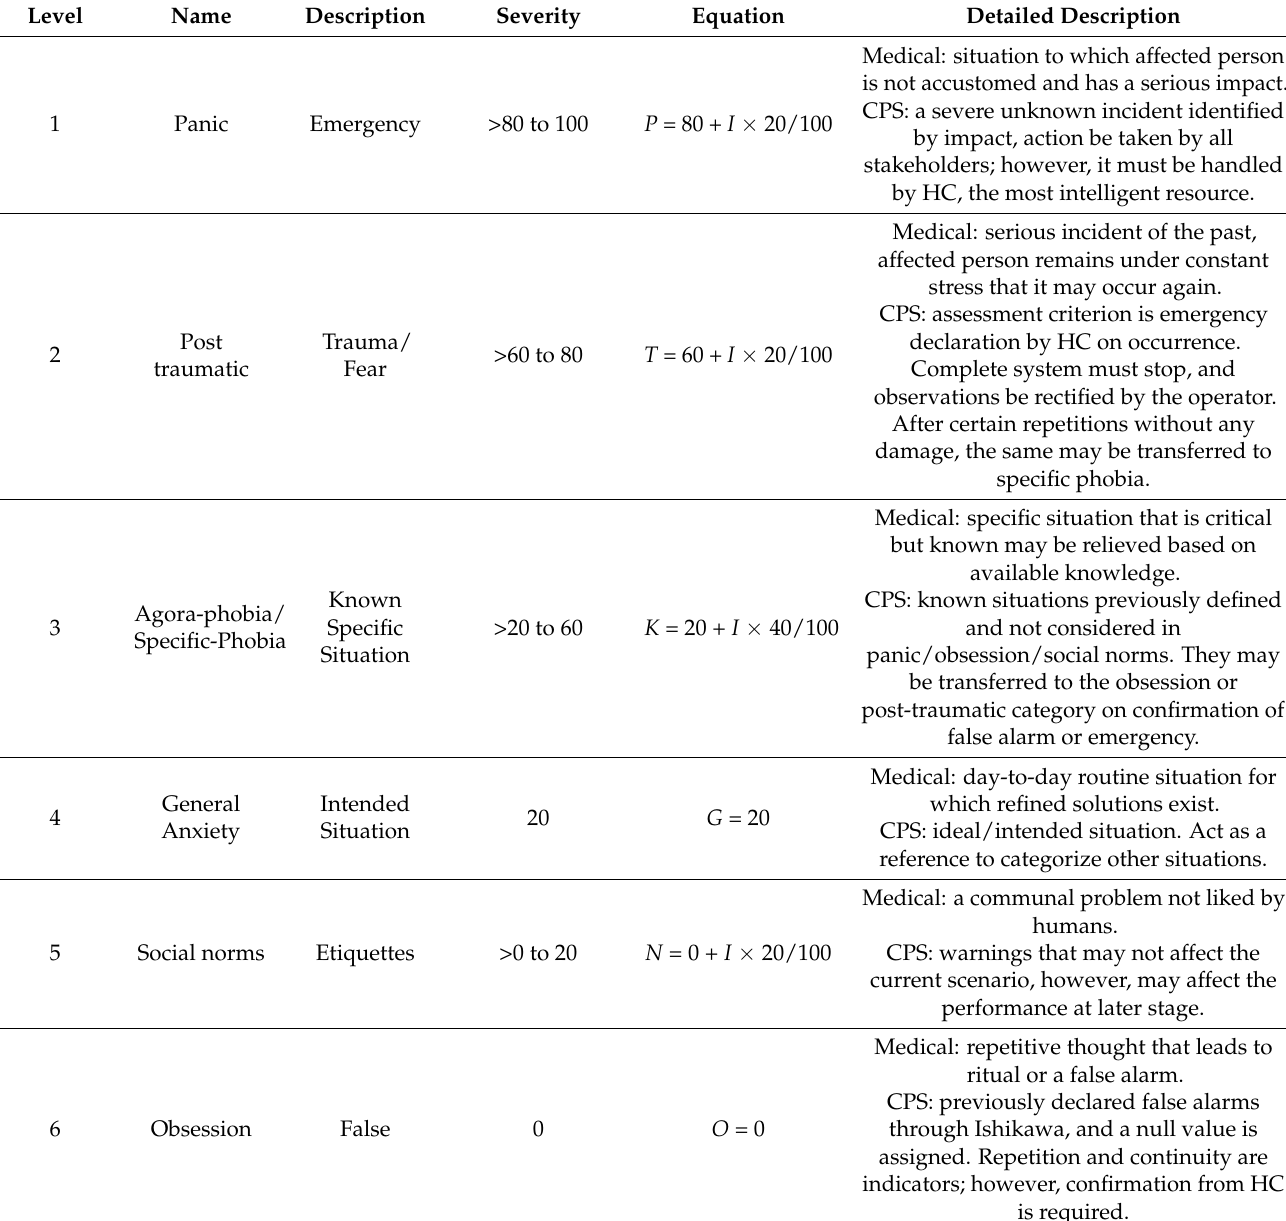
Table 1. Anxiety